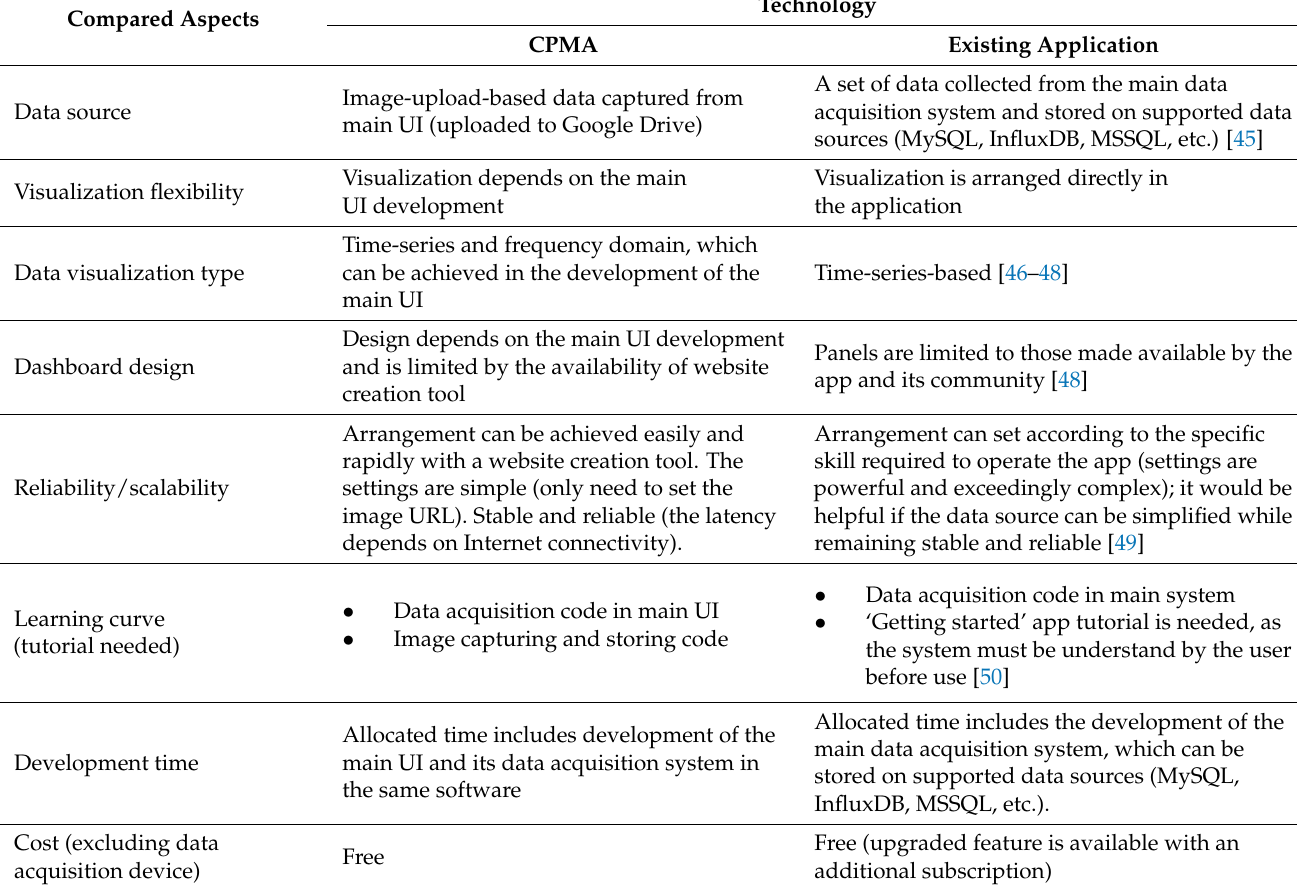
Table 1. Comparison table of CPMA and an existing